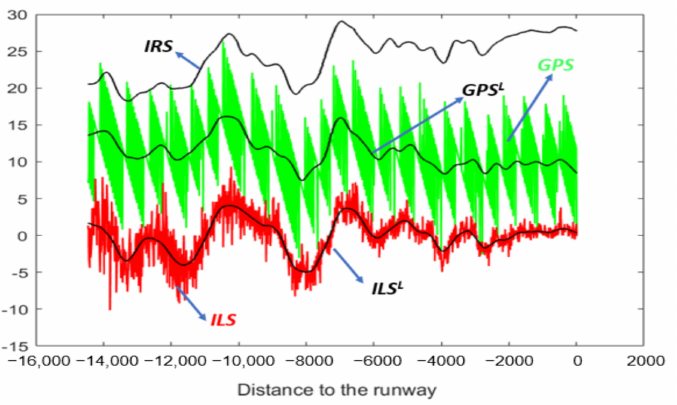
Figure 10. IRS, GPS, GPS L , ILS, and ILS L for the Y coordinate (real values of a landing).